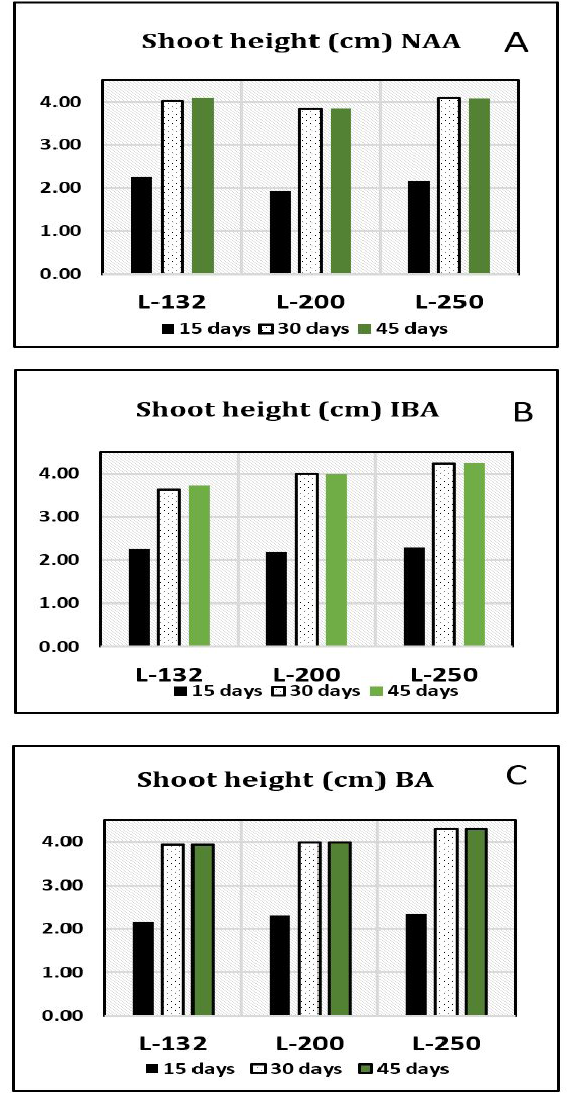
Figure 4. Comparison of morphological parameters of three clonal lines of thorny artichoke ( Cynara scolymus L.) in multiplication stage.